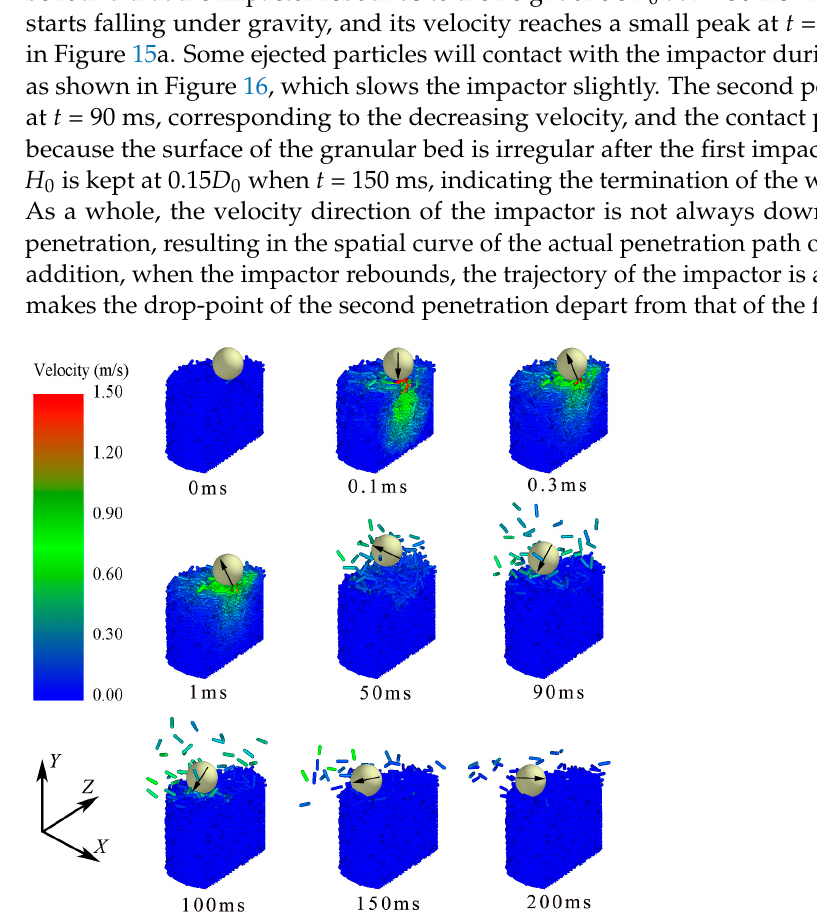
Figure 16. Velocity profiles of elongated particles ( L p = 6 mm) impacted by brass impactor. ( L p = 6 mm, μ p-p = 0.8, arrow represents velocity of impactor, whose color remains unchanged.)